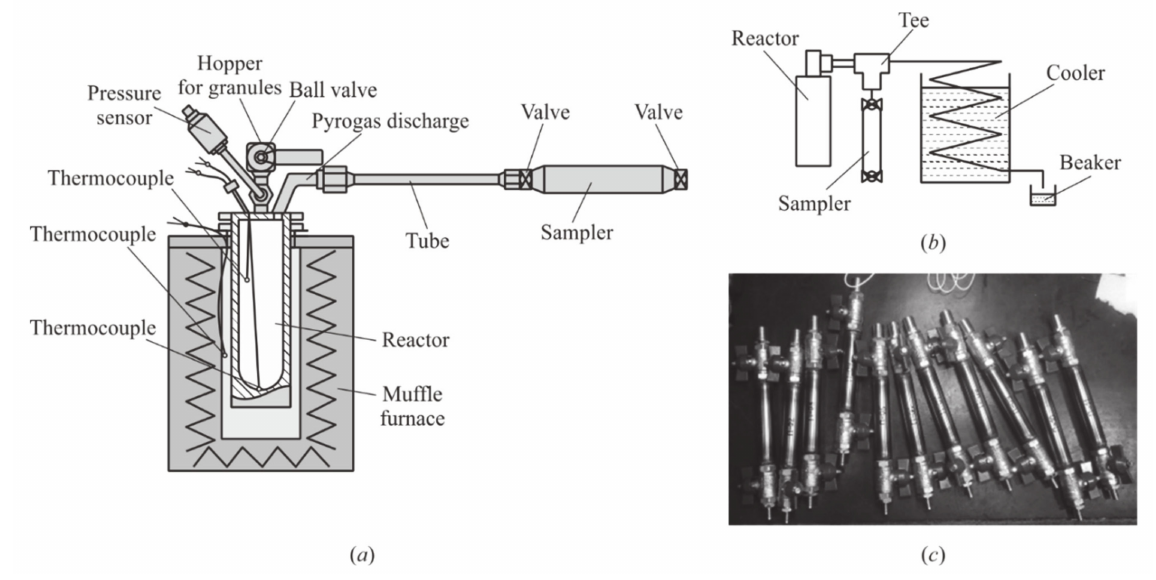
Figure 3. Schematic of GG with pyrogas sampling ( a ), simultaneous sampling of pyrogas and collection of liquid fraction ( b ), and photographs of samplers ( c